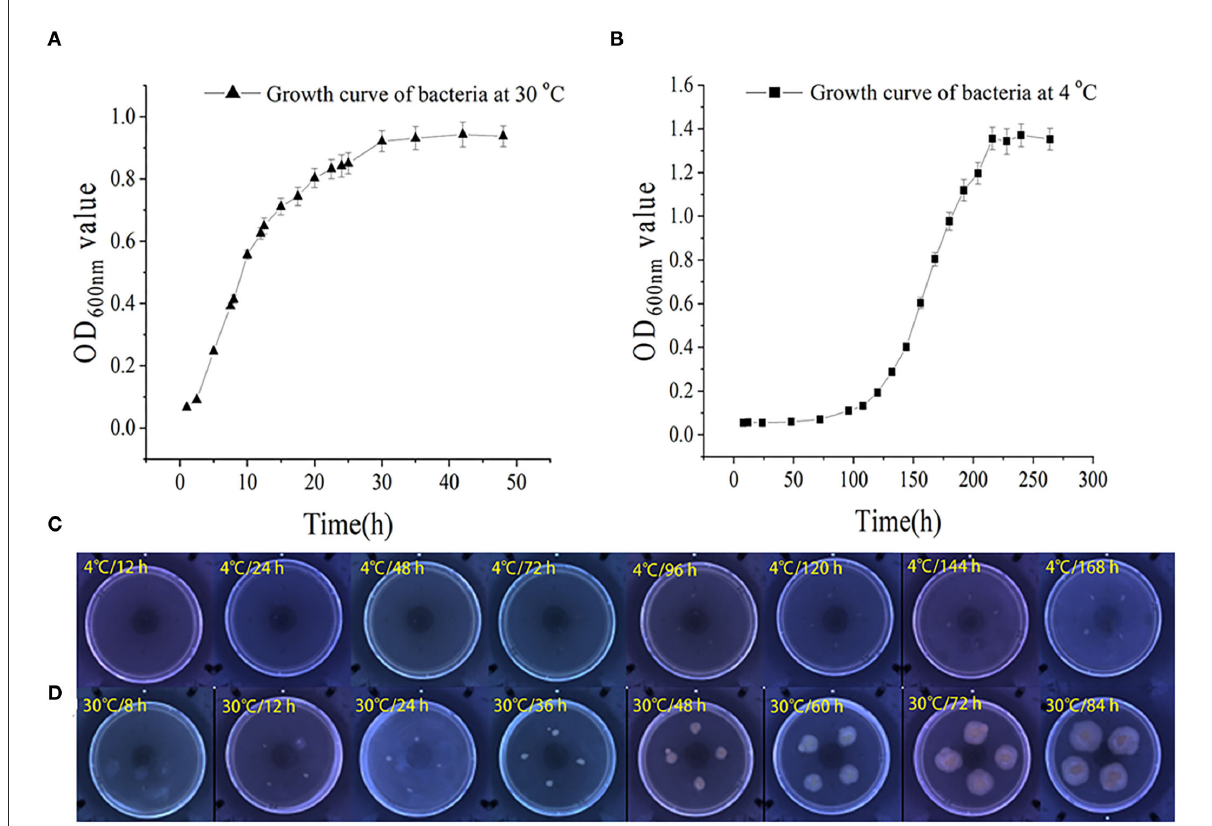
FIGURE1 Growth and swarming mobility of S. putrefaciens WS13. (A) Growth curve of S. putrefaciens WS13 under 30 ◦ C. (B) Growth curve of S. putrefaciens WS13 under 4 ◦ C. (C) Swarming mobility of S. putrefaciens WS13 under 4 ◦ C. (D) Swarming mobility of S. putrefaciens WS13 under 30 ◦